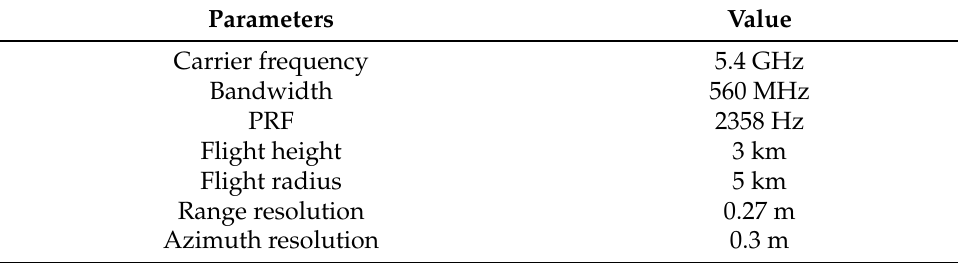
Table 1. Parameters of the C-band circular SAR